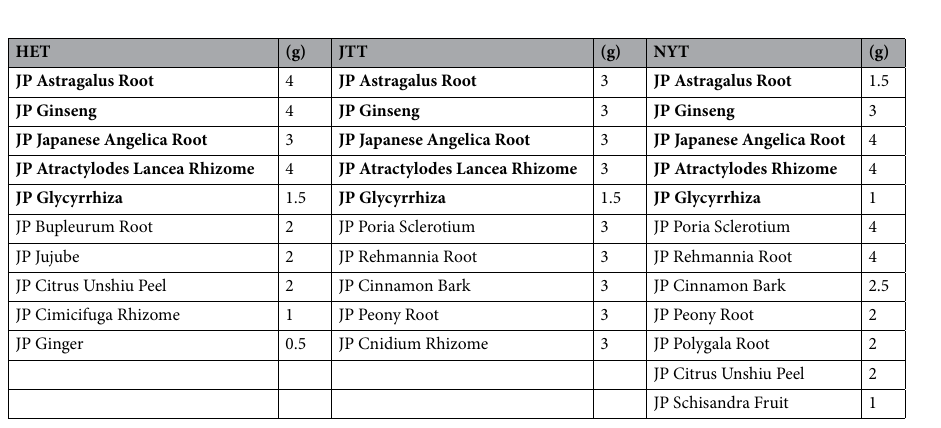
Figure 2. Kaplan–Meier curves until VRE negative conversion by hochuekkito. Time until the achievement of VRE negative conversion was compared between patients treated with hochuekkito and others without use of any Kampo medicine in the whole population and in those with nasogastric feeding tubes. VRE vancomycin- resistant enterococcus.